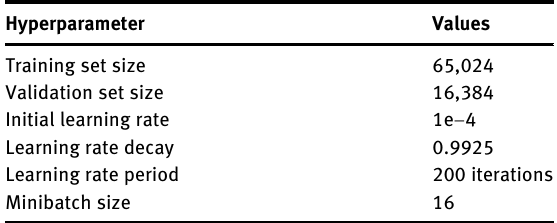
Table  : Choices are shown for each hyperparameter. These termsdictatethe progressionof thetraining process.The same hyperparameters were used for training both halves of the